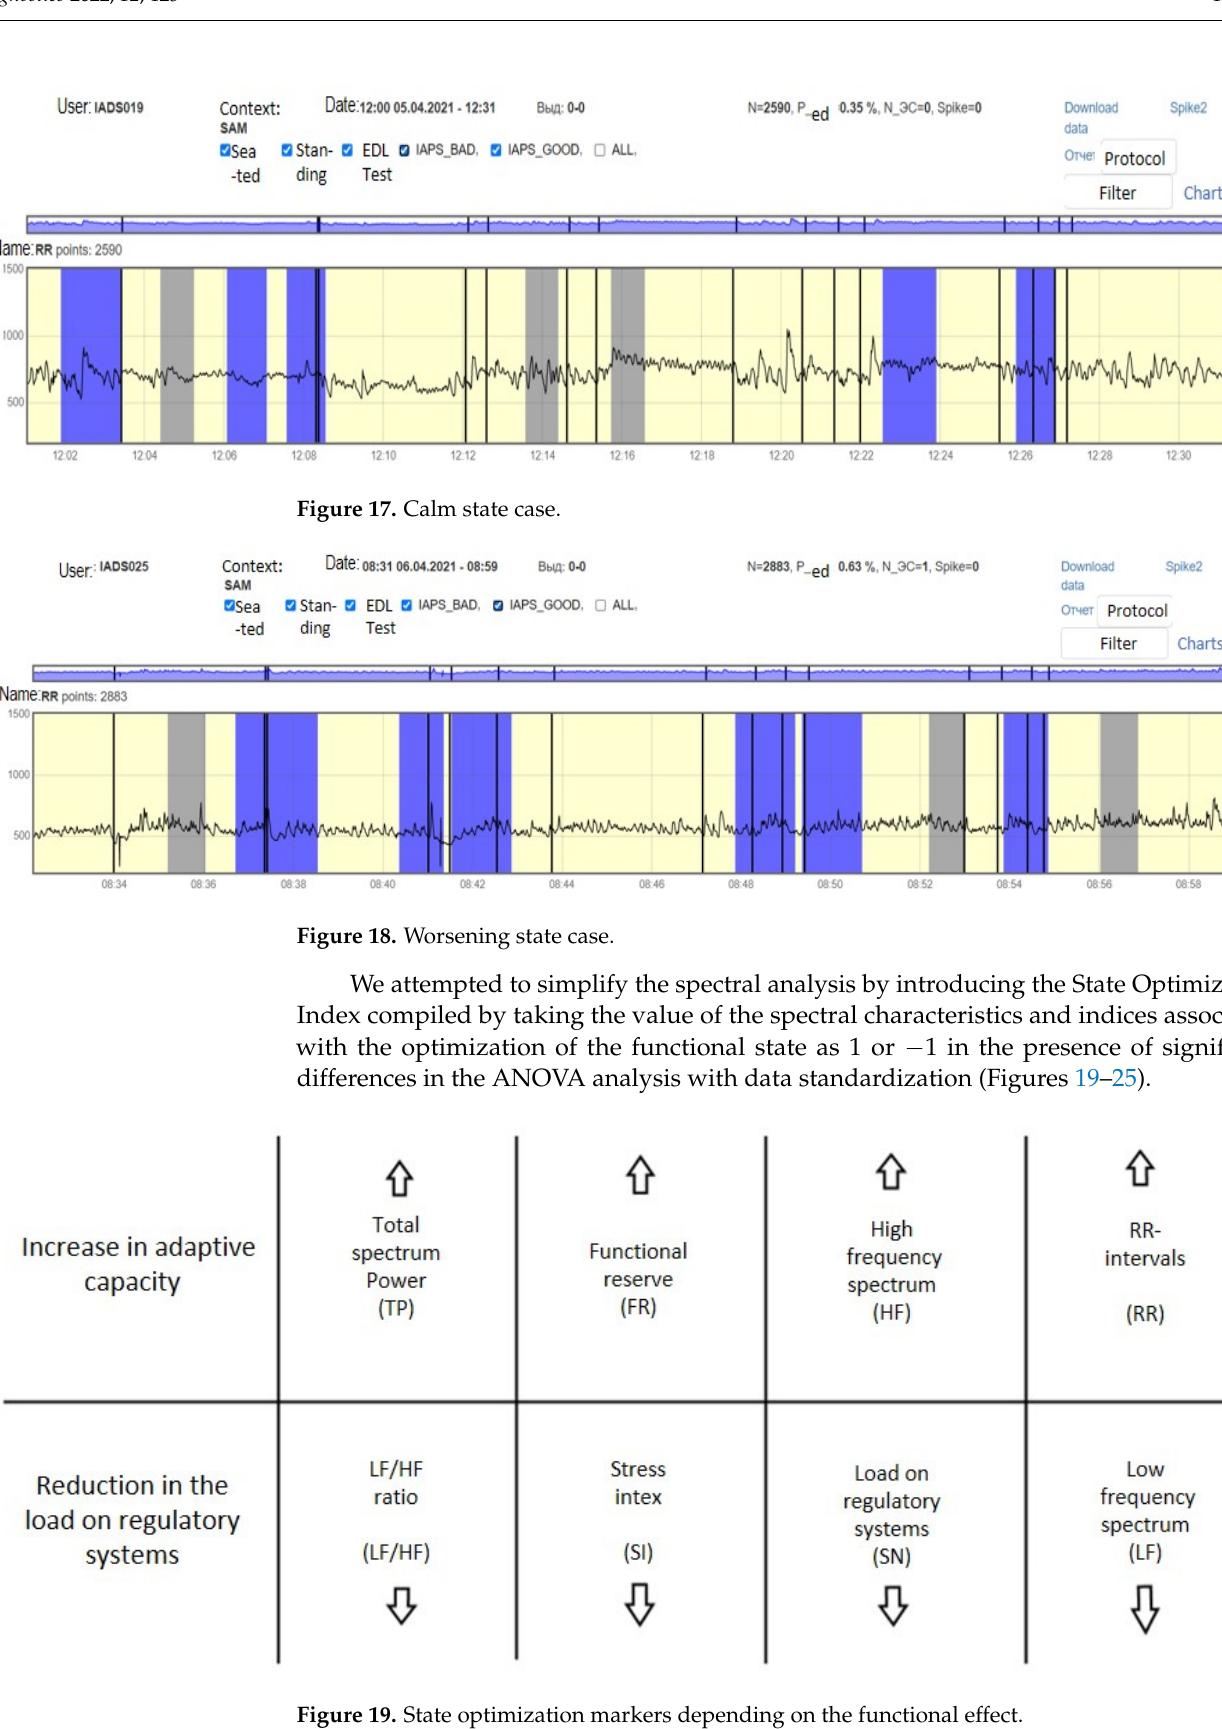
Figure 19. State optimization markers depending on the functional effect.